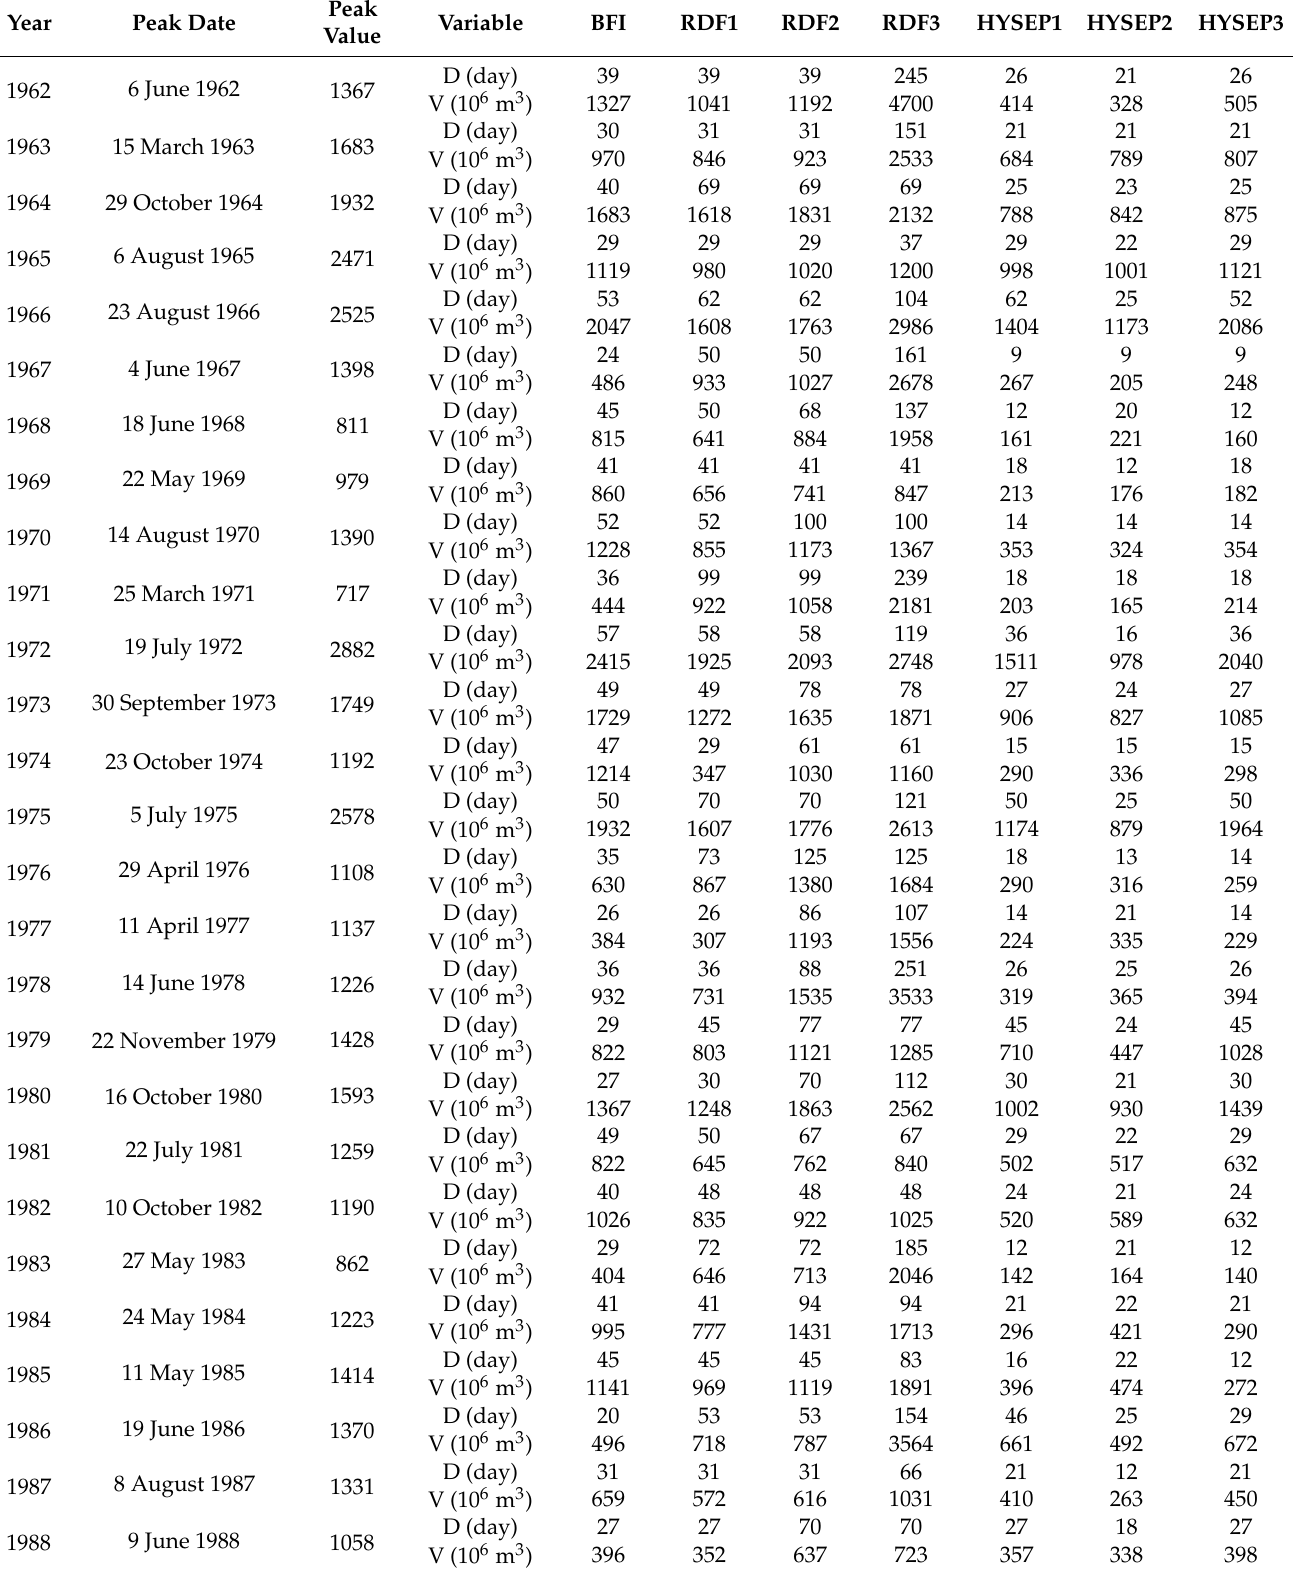
Table 5. Example of derived AM samples for flood hydrograph duration and flood hydrograph volume for seven different baseflow separation methods on the Terezino Polje GS on the Drava